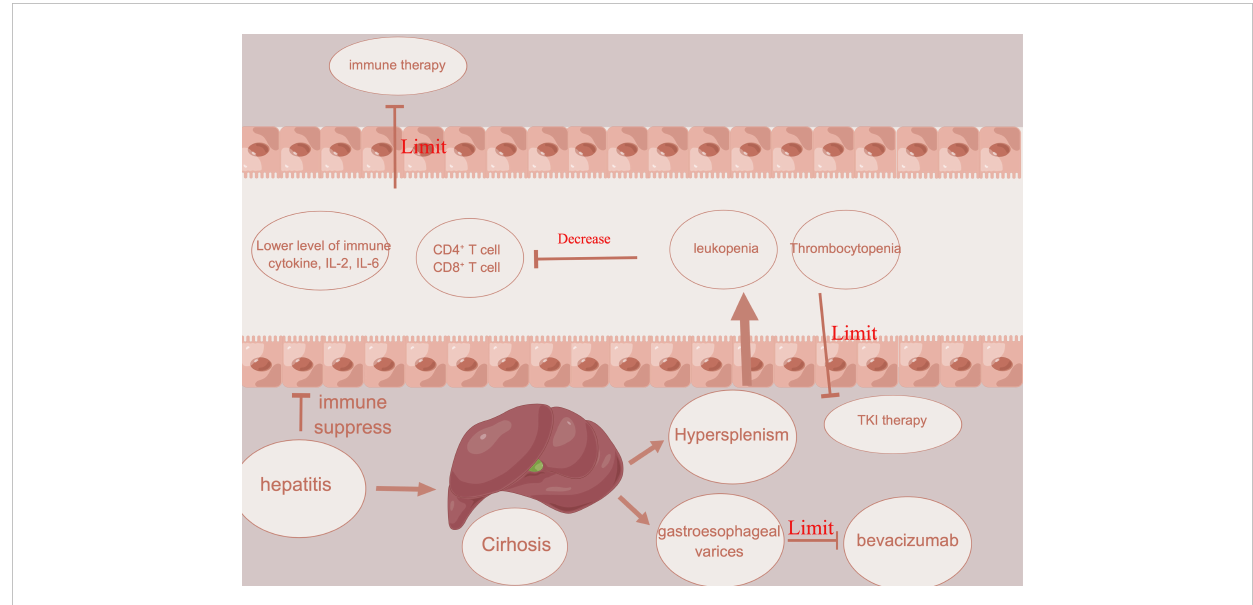
FIGURE 2 Illustration about how hepatitis, cirrhosis, and portal hypertension limit the usage of immune therapy and angiogenesis